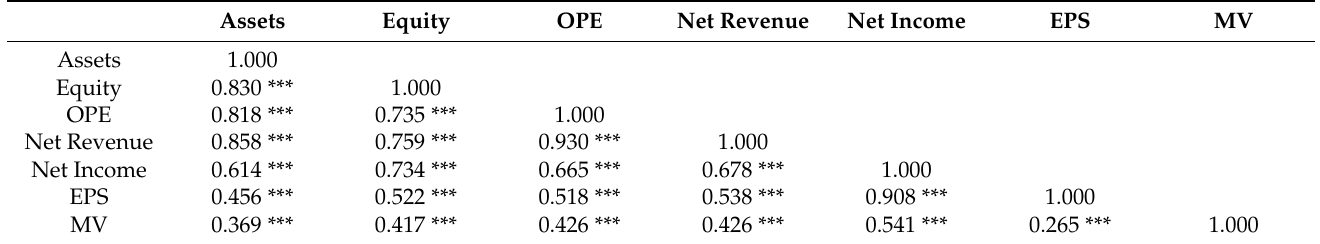
Table 3. Correlation matrix of the selected variables from the value creation